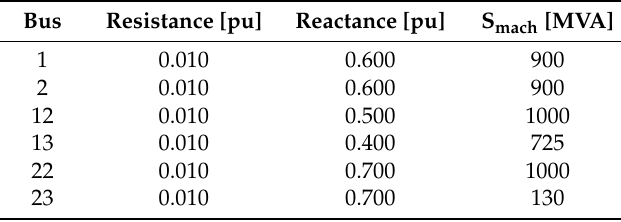
Table 3. Generators’ quadratic cost function coefficients.